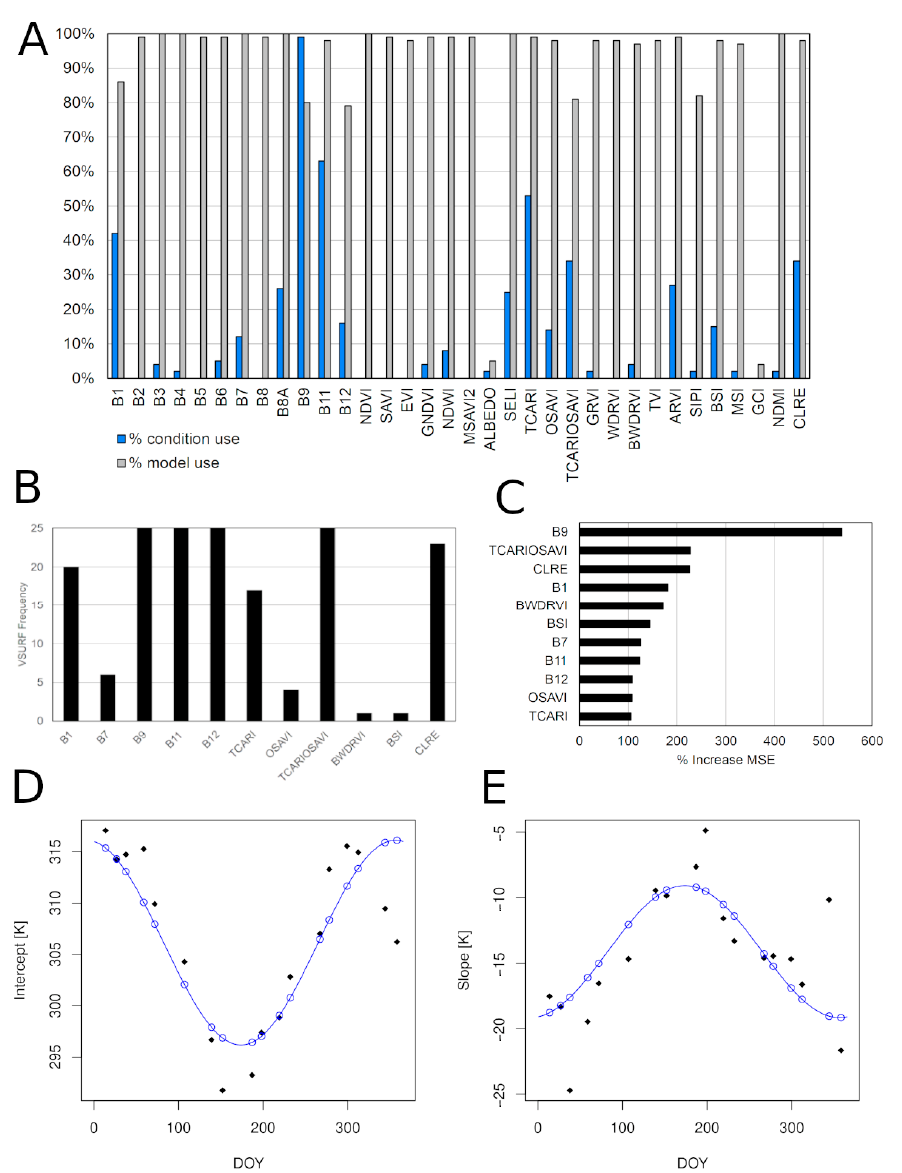
Figure 2. Cubist ( A ), variable selection for random forest algorithm ( B ), random forest ( C ), and sinusoidal ( D , E ) model calibration results.